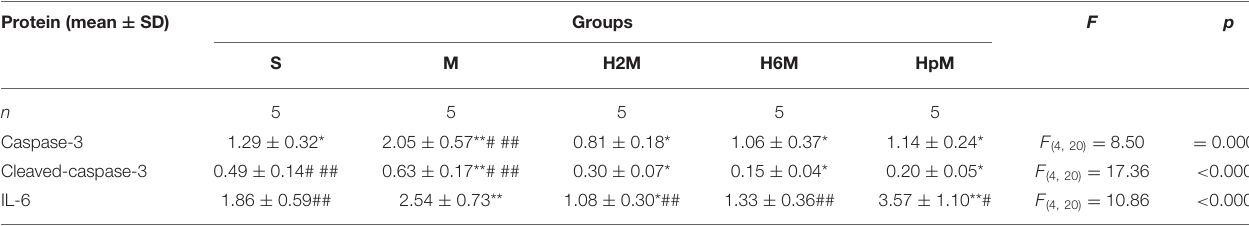
TABLE 3 | Mean gray value analyzed according to western blotting results of IL-6, caspase-3, and cleaved-caspase-3. Protein (mean ± SD) Groups F